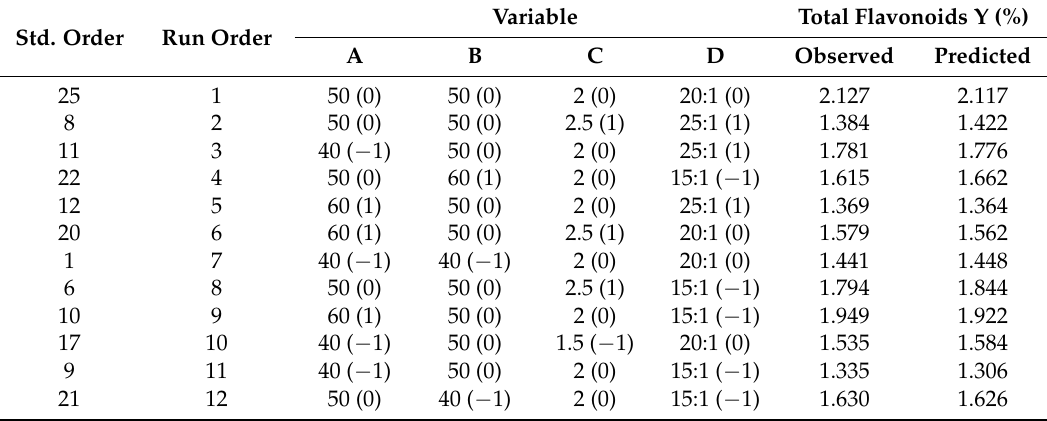
Table 1. Experimental design and results for response surface analysis.